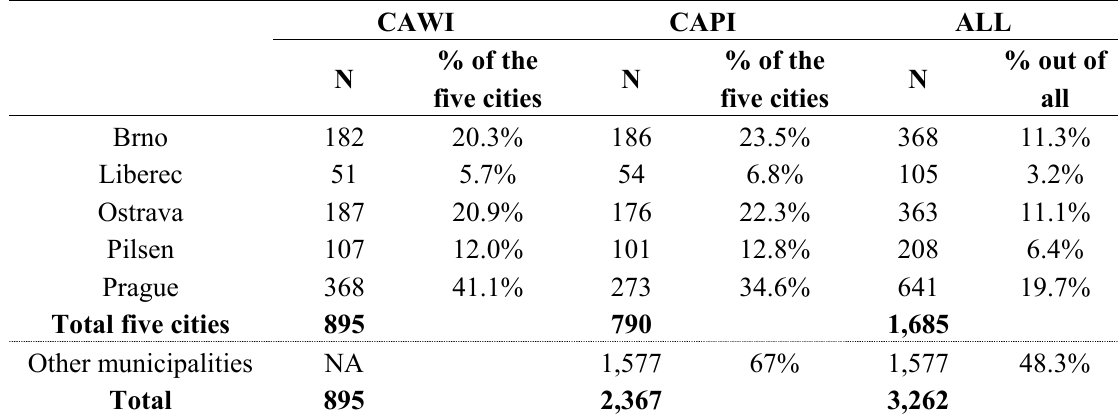
Table 2. Description of the sample.